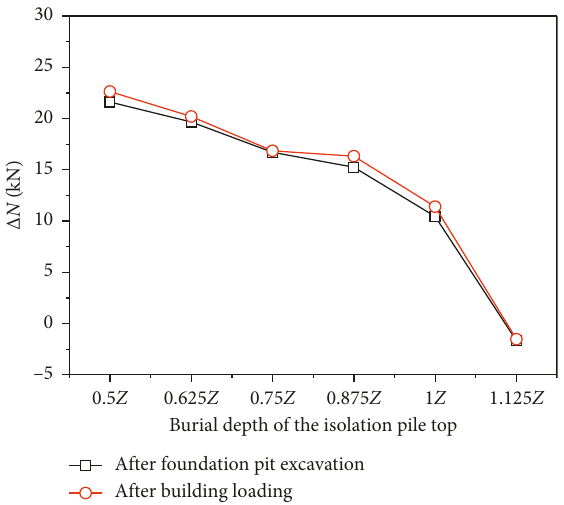
Figure 29: Difference between the additional shear